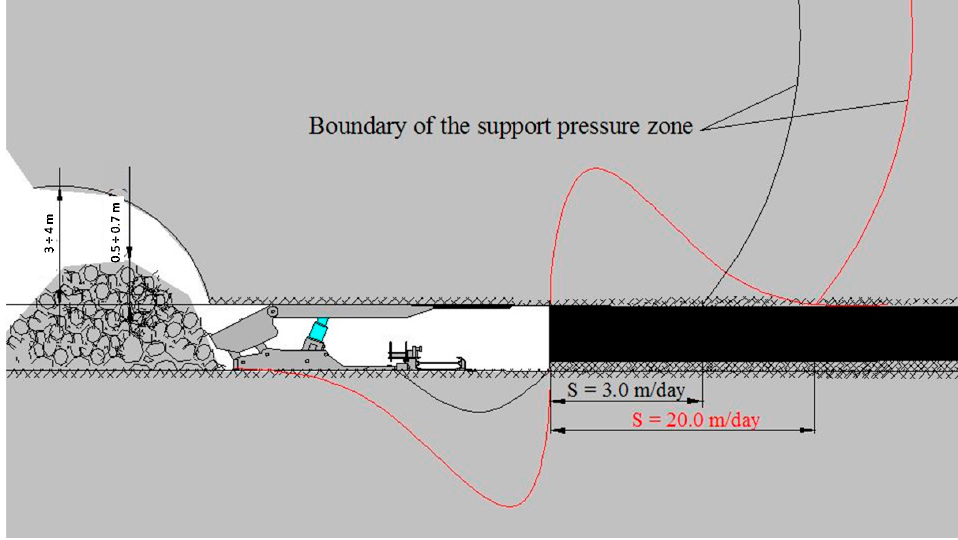
Figure 9. Effect of the face advance rate on the distribution of support rock